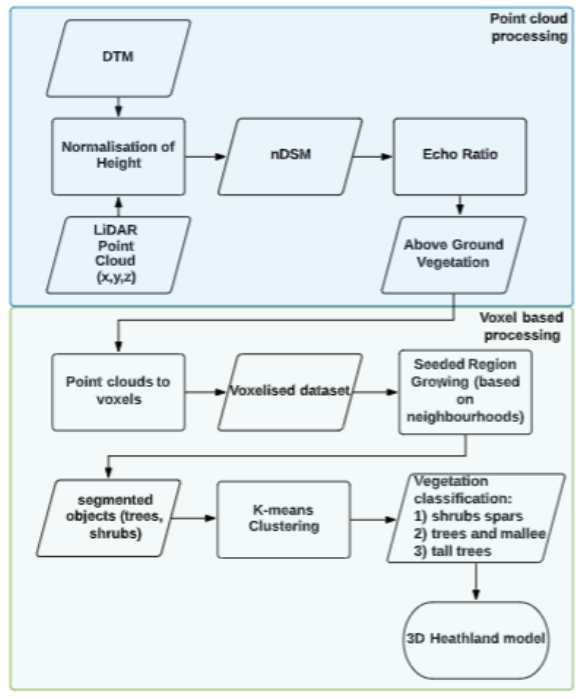
Figure 2. Workflow of the three-dimensional modelling of heathland, rectangular boxes indicate